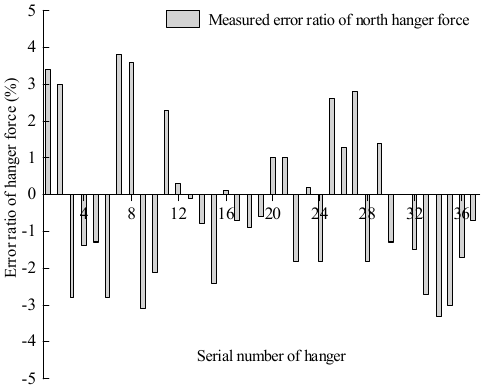
Figure 19. Measured error of the final hanger force. Figure 20. Comparison of the final c able alignment.